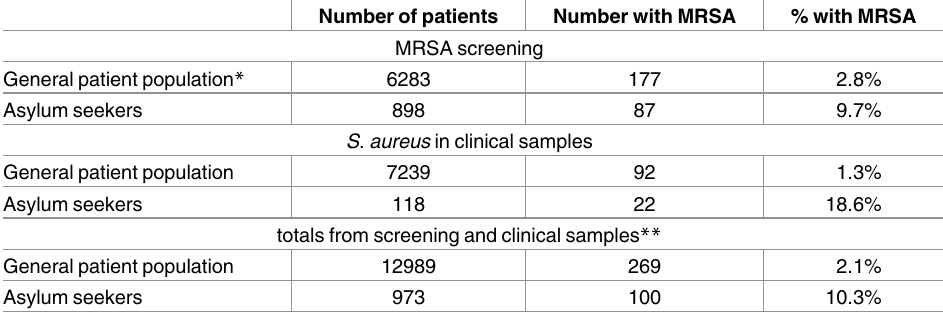
Table 1. Results of MRSA screening and MRSA among S . aureus isolates cultured from clinical sam- ples, during 2014–2015, at the Certe